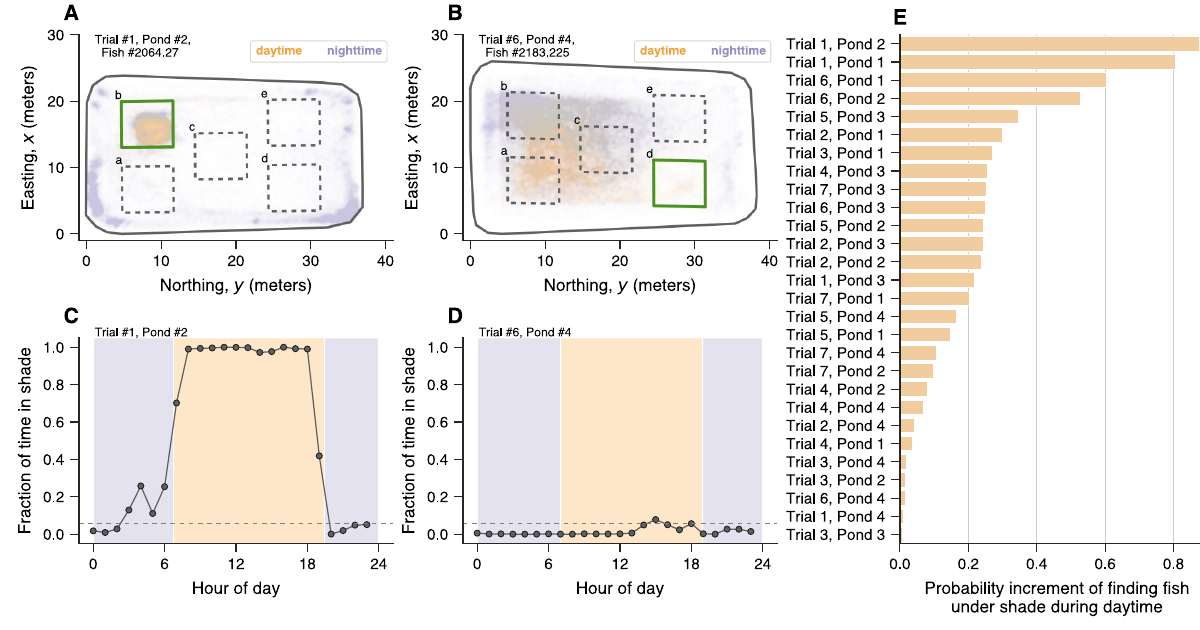
Figure 1. Silver Carp prefer shade structures during daylight hours. ( A , B ) Density maps of two fish positions from two different trials and ponds. Orange hues indicate positions recorded during daylight hours, while purple hues represent positions collected at night. The gray solid lines represent the pond limits and the thick green squares indicate the actual location of the shade structure in the particular trials and ponds shown in the top left of the panels. The dashed squares indicated by lowercase letters (from ‘a’ to ‘e’) represent all possible shade positions. We observe that the fish in ( A ) has an extreme preference for the shaded area during daylight hours, while the same preference is absent for the fish in ( B ). ( C , D ) Differences in shade selection as a function of the hour of day. The circles show the fraction of all fish positions recorded under the shade structures within a 1-h time window for two trials and ponds. The dashed line represents the expected fraction of positions under shade if fish would move randomly over the ponds, and the background colors indicate daytime (orange) and nighttime (purple). Fish from pond #2 remained under shade during nearly all daylight hours along the two observation days in trial #1 and avoided shade at night. Fish from pond #4 selected the shade structure much more rarely during daylight hours (particularly in the mornings) in trial #6. ( E ) Probability increment of finding a position under a shade structure during daylight hours, as estimated via logistic regression for each trial and pond. The relationship between a fish selecting shade or not and the binary independent variable of day or night varies substantially but is nonetheless significant for all trials and ponds ( p -values < 0.001